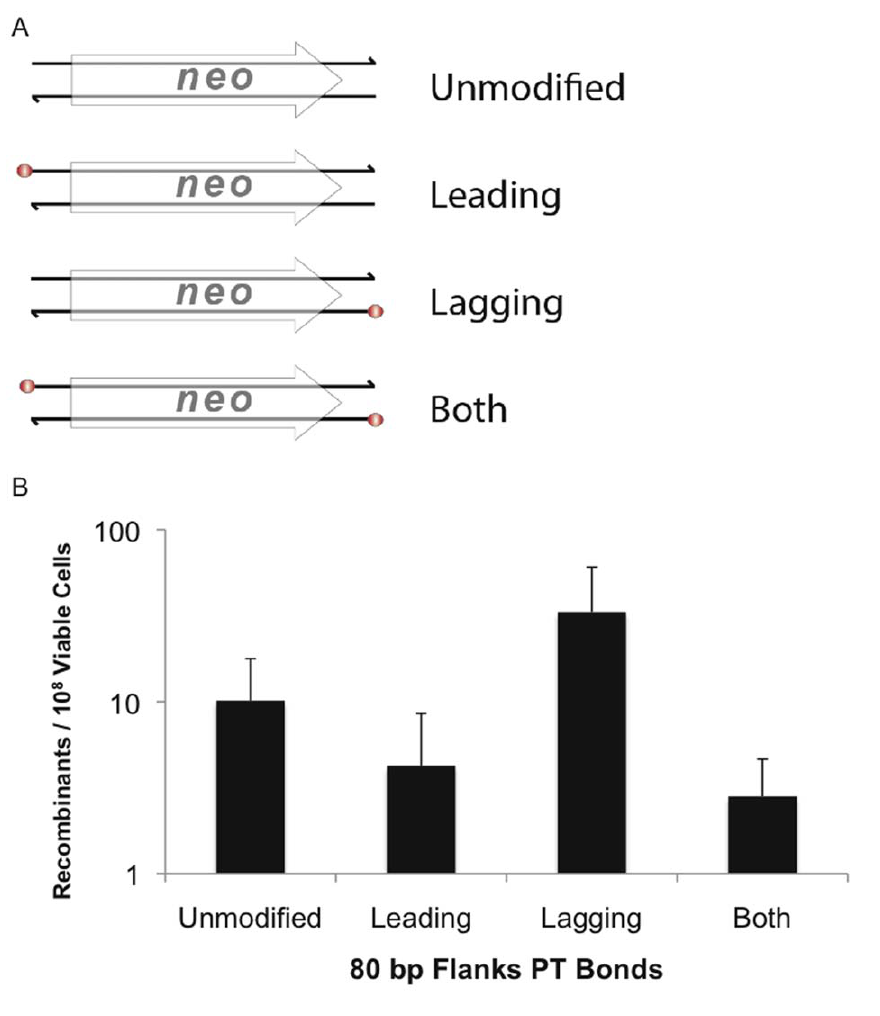
Figure 3. Phosphorothioate bonds on the matching lagging strand provide a modest increase in recombineering. (A) Locations of the 5 9 phosphorothioate bonds at the four terminal nucleotides are indicated as red spheres. Leading, Lagging and Both indicate the location of the 5 9 phosphorothioate bonds on the respective strands of the substrates relative to the target location. (B) Recombination frequency for 80 nt flank protected substrates. 200 ng of each substrate was used in each electroporation. The results are the average of at least four independent replicates, error bars indicate standard deviation.